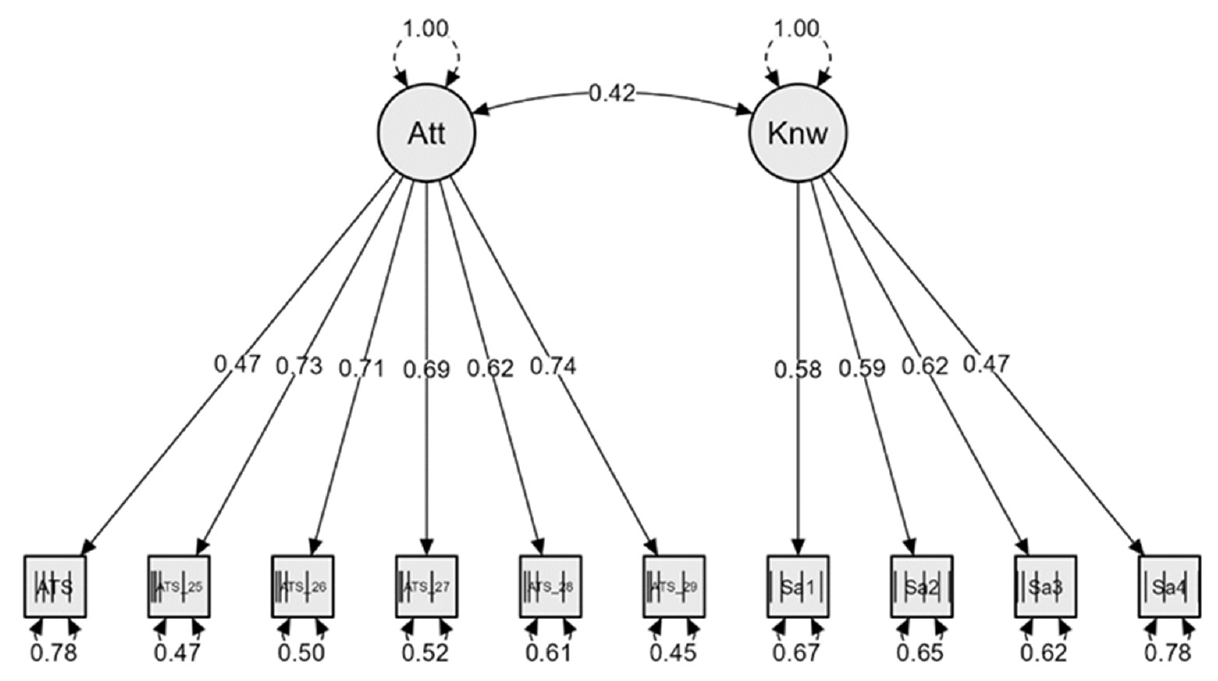
Figure 4. Factor loadings for the security area. Factor loadings for the area of communication and collaboration ranged from 0.50 to 0.83, which is considered acceptable and significant (Figure